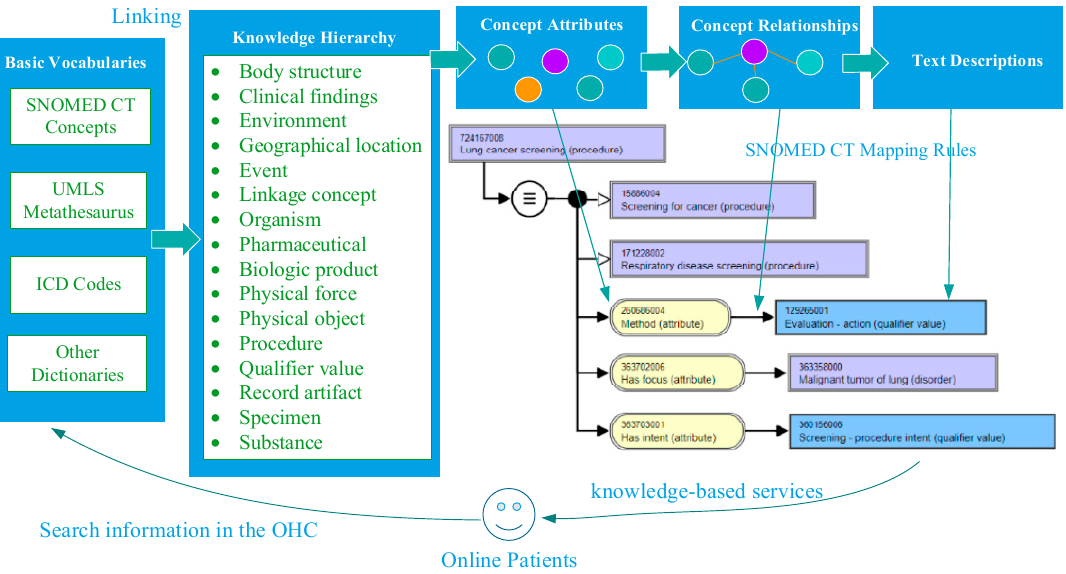
Figure 1. Overview of knowledge sources in the medical and healthcare field. Table 1. Element-mapping relationships between the UMLS Metathesaurus and our Domain- Knowledge Support Framework (DKSF).